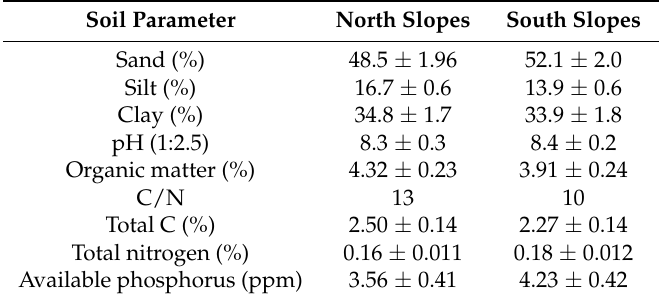
Table 1. Mean ( ± SE) soil characteristics (0–10 cm depth) in the study area. Sample data n = 32 (1 sample per plot; 16 samples for each topographic aspect). Texture was determined with a Bouyoucos densimeter, pH with a pH meter, total organic C and organic matter (%) by the Walkley–Black method, total N (%) by the Kjeldahl method, and bioavailable P following the method of Olsen. Soil Parameter North